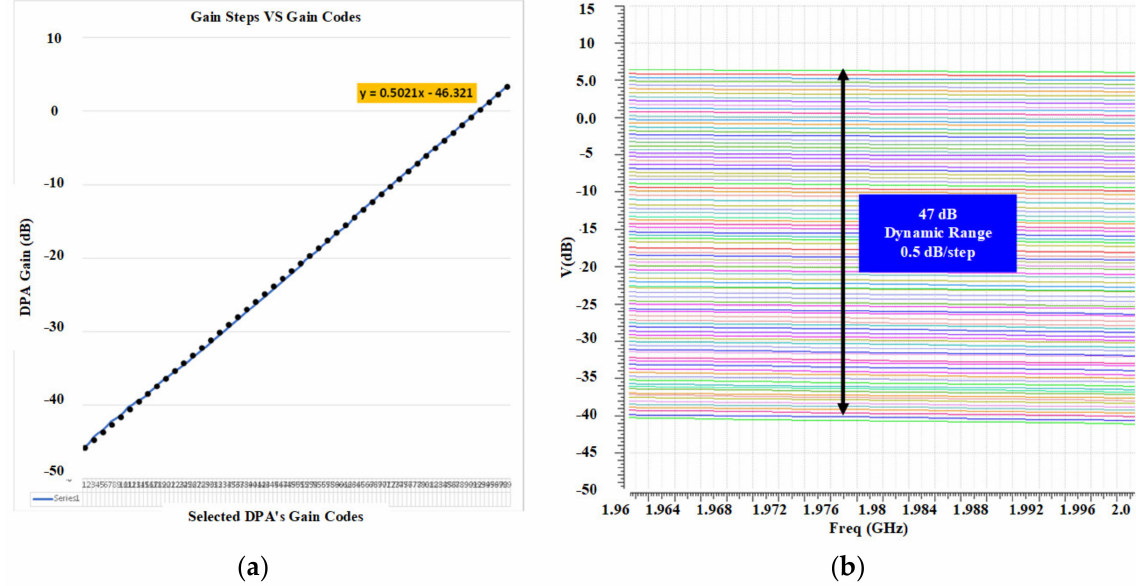
Figure 9. Post-layout simulation results illustrating ( a ) the linear gain steps by the selected gain control codes and ( b ) for the gain-steps accuracy and the dynamic range.